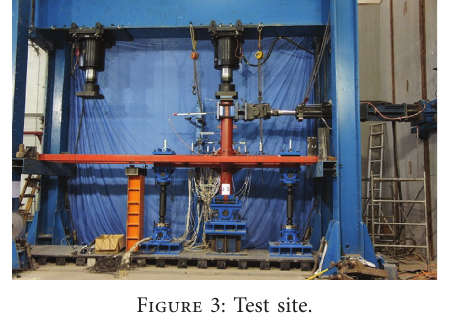
Figure 3: Test site.